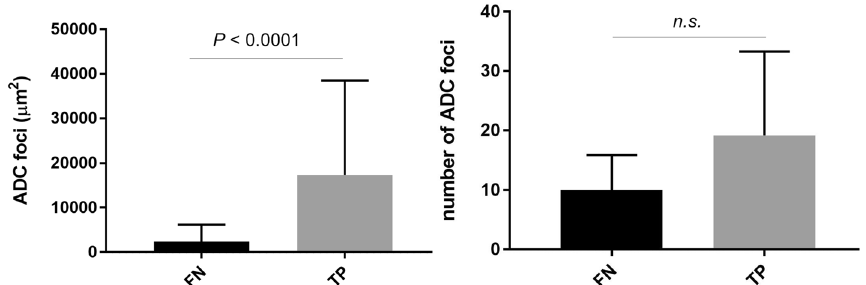
Figure 4. Effect of area and number of pancreatic ductal adenocarcinoma (PDAC) foci on false-negatives. The area of ADC foci was significantly larger in the true positives than in the false negatives (left panel). On the other hand, there was no significant difference in the number of ADC foci between the true positives and false negatives (right